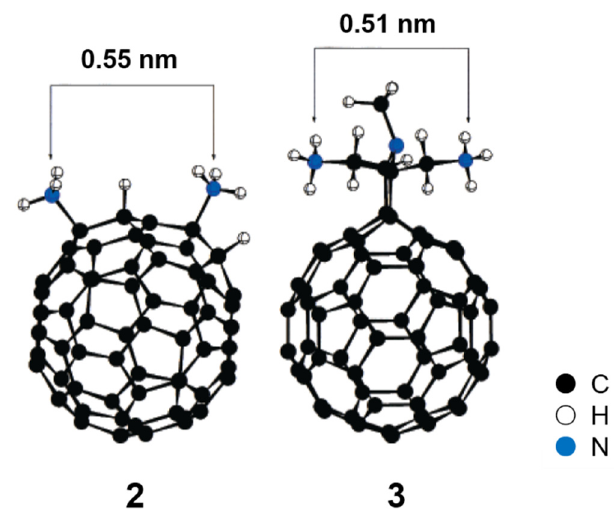
Figure 3. PM3-minimized structures of compounds 2 and 3 . Adapted with permission from Ref. [52]. Copyright 2000 American Chemical Society.